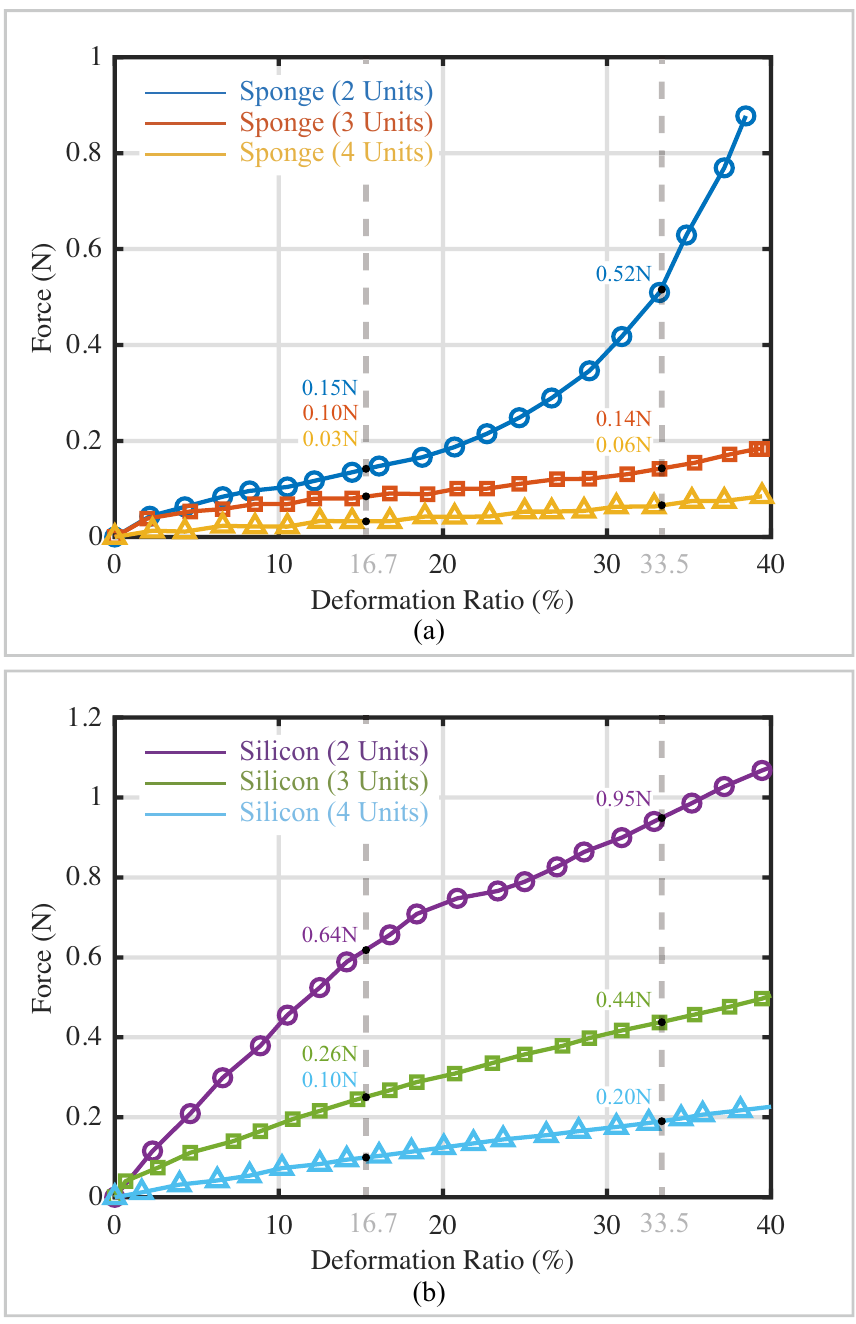
Figure 8. Results of the sensor stretching experiment. ( a ) Experimental results of the conductive sponge material. ( b ) Experimental results of the conductive silicon material. Resistive force of the sensors at a 16.7% deformation ratio (respective to a 45 ◦ actuator overall bending angle) and 33.5% deformation ratio (respective to 90 ◦ actuator overall bending angle) are